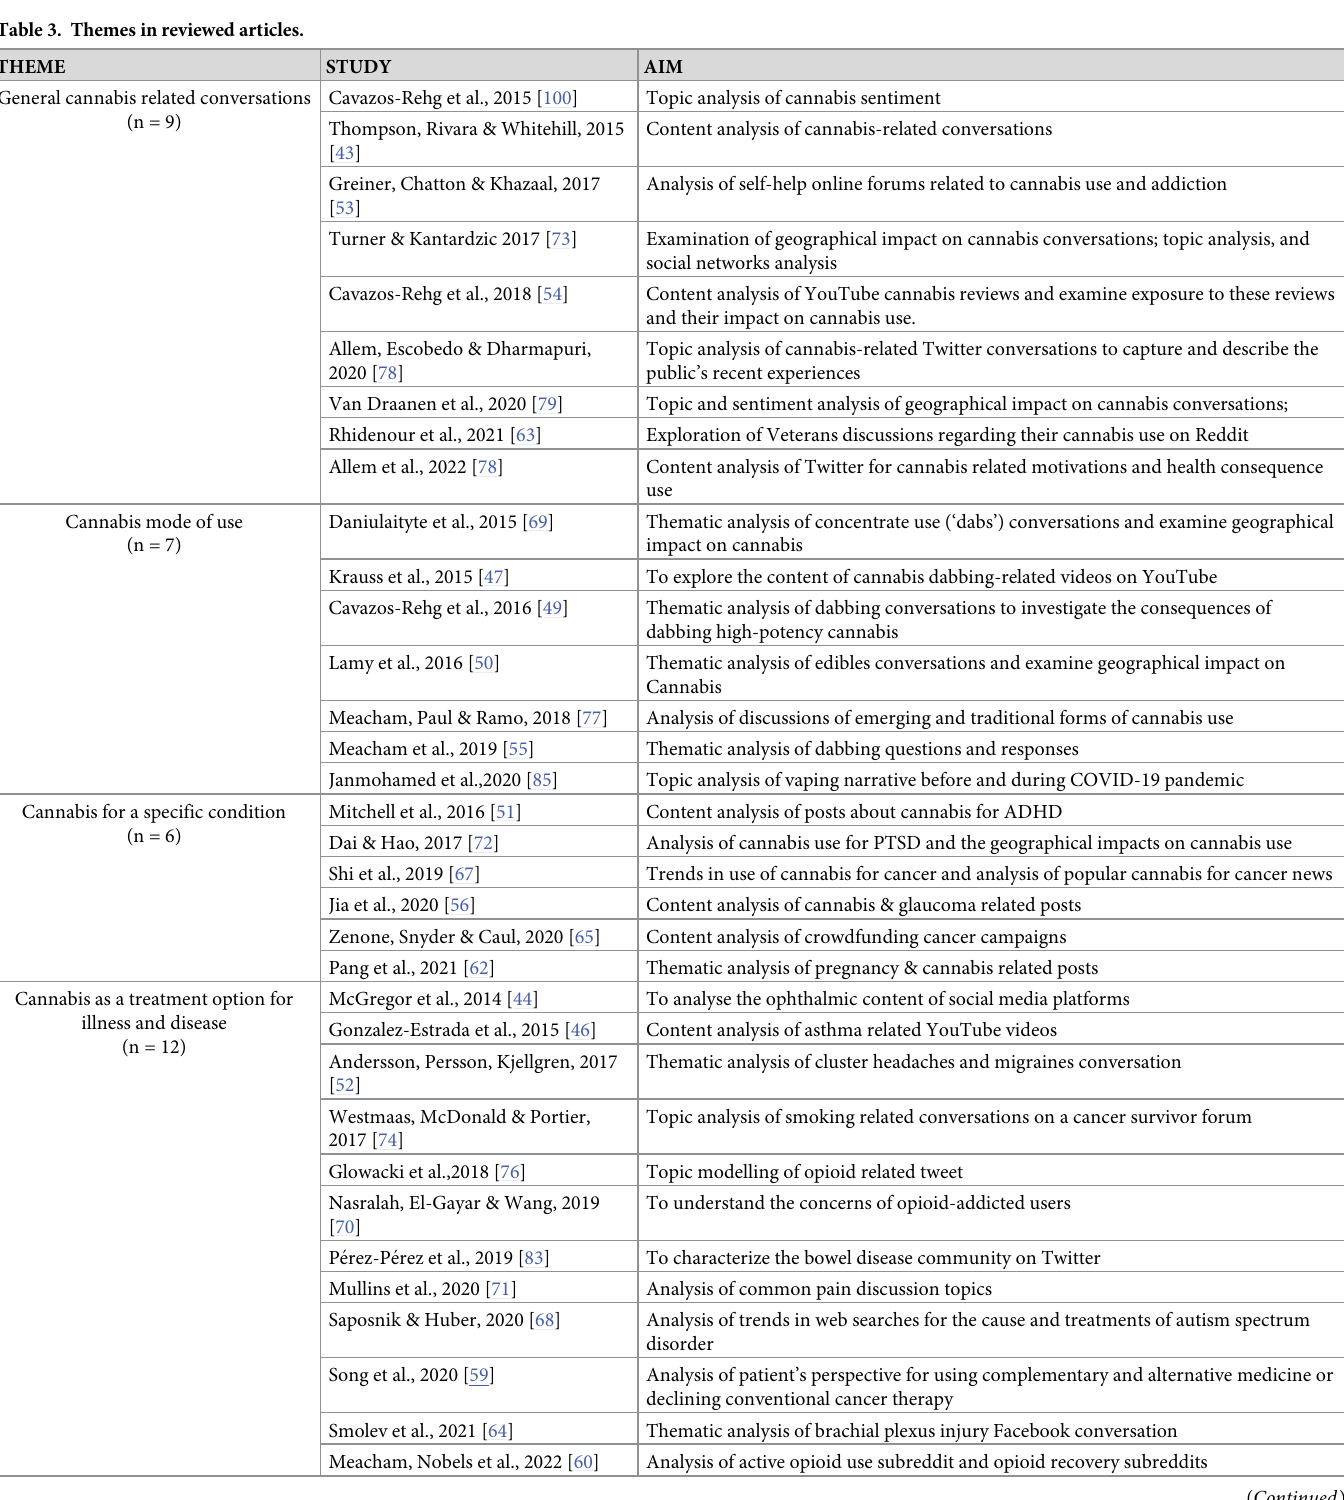
Table 3. Themes in reviewed